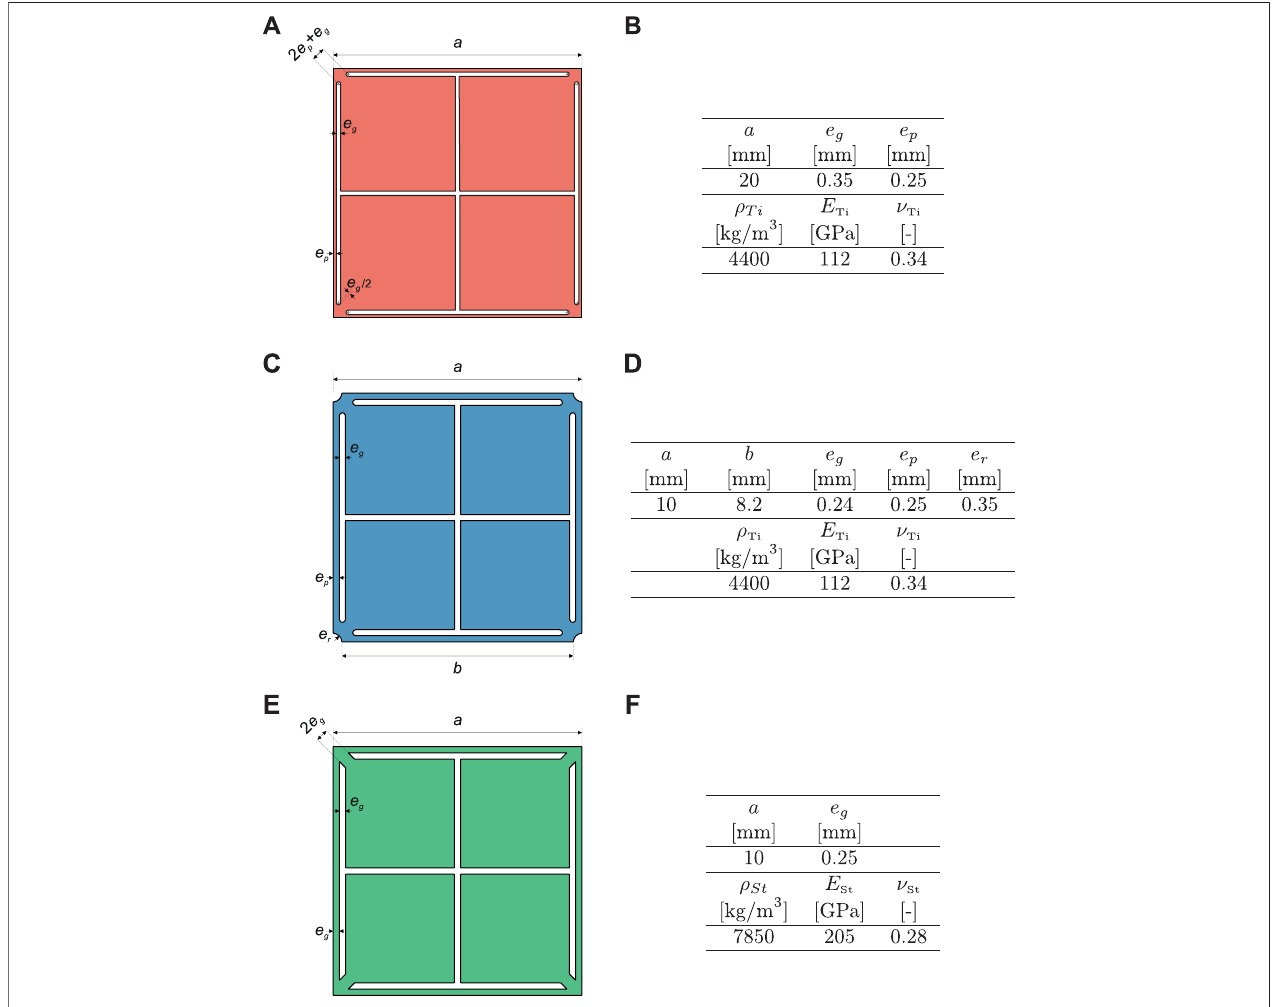
FIGURE 2 | (A) unit cell giving rise to the metamaterial 1, or in short MM1 . (B) Table geometry and material properties of the unit cell: ρ Ti , E Ti , and ] Ti stand for the density, Young modulus and Poisson ’ s ratio of titanium, respectively. (C) unit cell giving rise to the metamaterial 2, or in short MM2 . (D) Table geometry and material propertiesoftheunitcell: ρ Ti , E Ti ,and ] Ti standforthedensity,YoungmodulusandPoisson ’ sratiooftitanium,respectively. (E) unitcellgivingrisetothemetamaterial3,or in short MM3 . (F) Table geometry and material properties of the unit cell: ρ St , E St , and ] St stand for the density, Young modulus and Poisson ’ s ratio of steel,